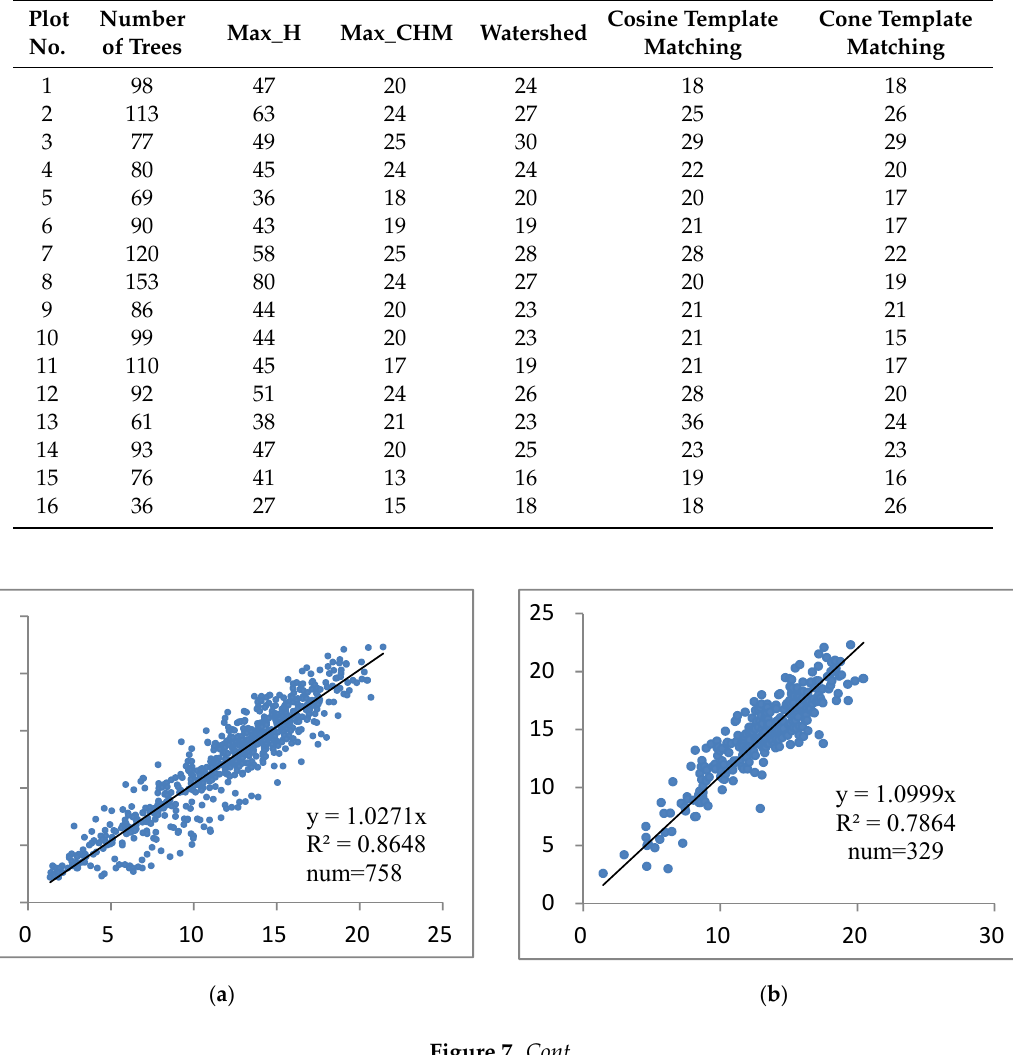
Table 5. The counts of tree extracted by these five algorithms in 16 super plots.